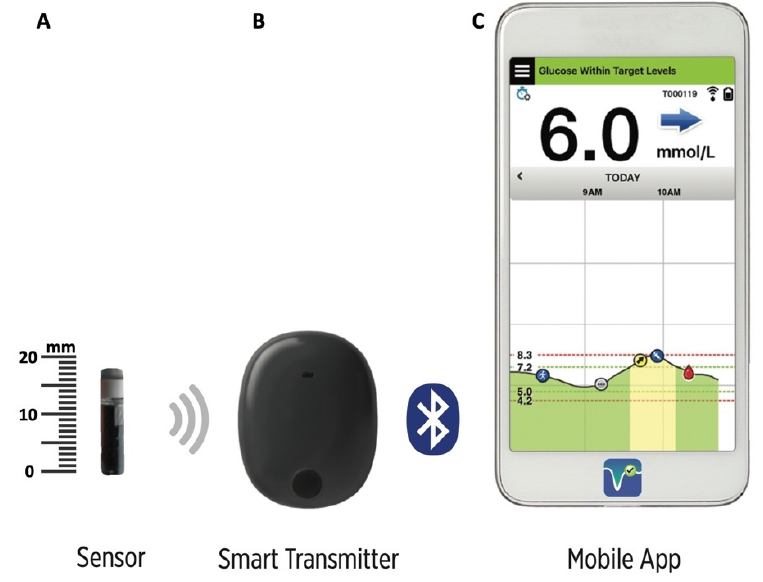
Figure 1. Eversense XL consists of the following: ( A ) the sensor (18.3 mm in length and 3.5 mm in diameter) which is implanted in the subcutaneous tissue; ( B ) the smart transmitter; ( C ) the mobile application which displays glucose information on a handheld device.